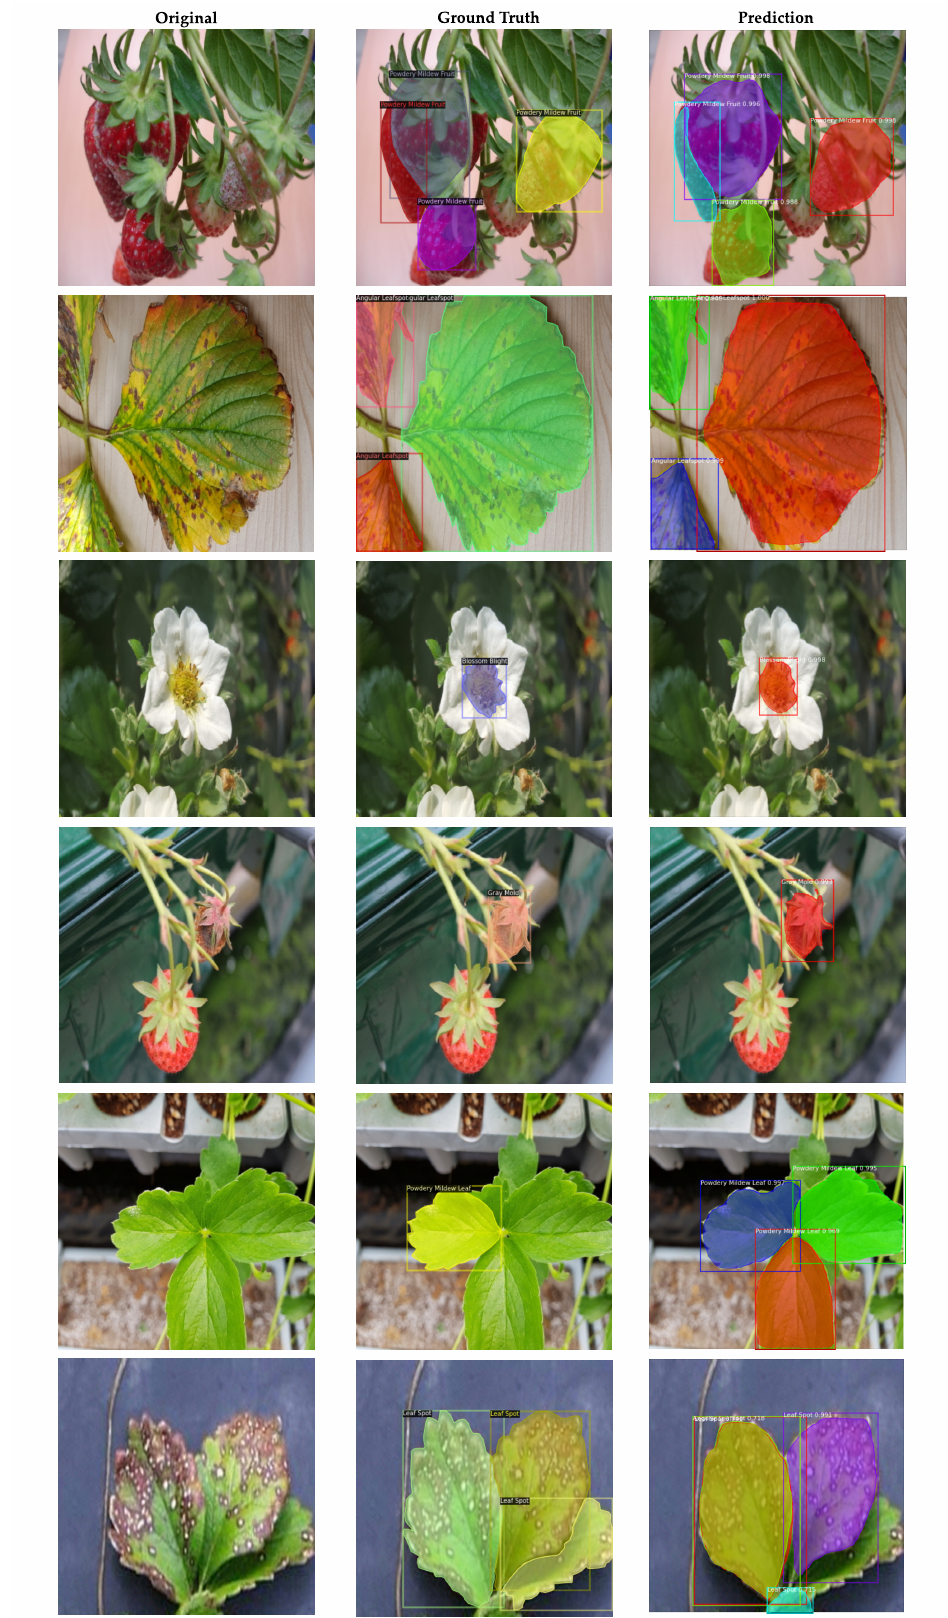
Figure 6. Predictions on the test dataset by the ResNet101 Network. The last two rows visualize some of the misclassifications done by our